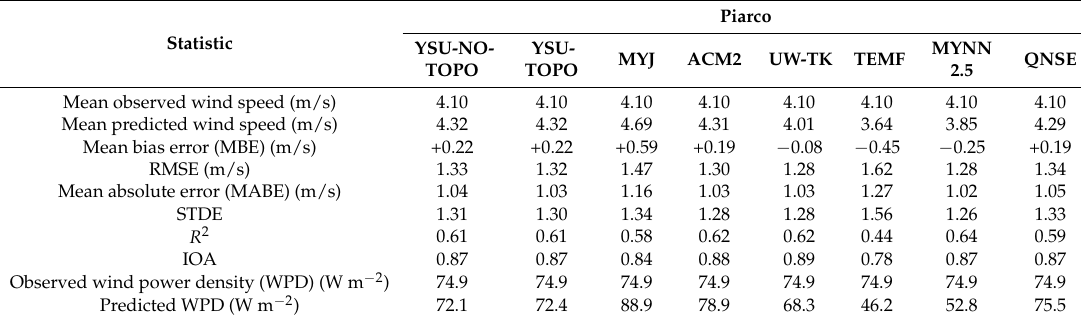
Table 2. Error statistics for wind speed and wind direction at the 10 m height above ground, and an estimate of the monthly wind power density for April 2003 at Piarco. Error statistics were computed for 720 h of simulated winds. Statistic